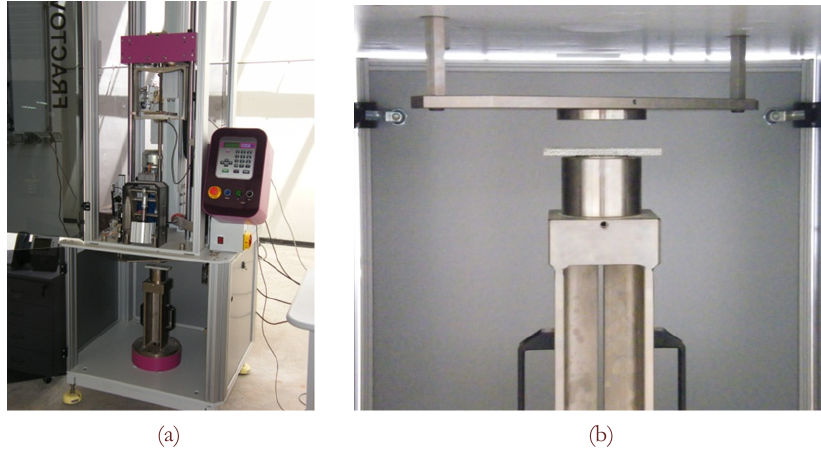
Figure 2: a) Drop-weight impact test machine; b) Clamping